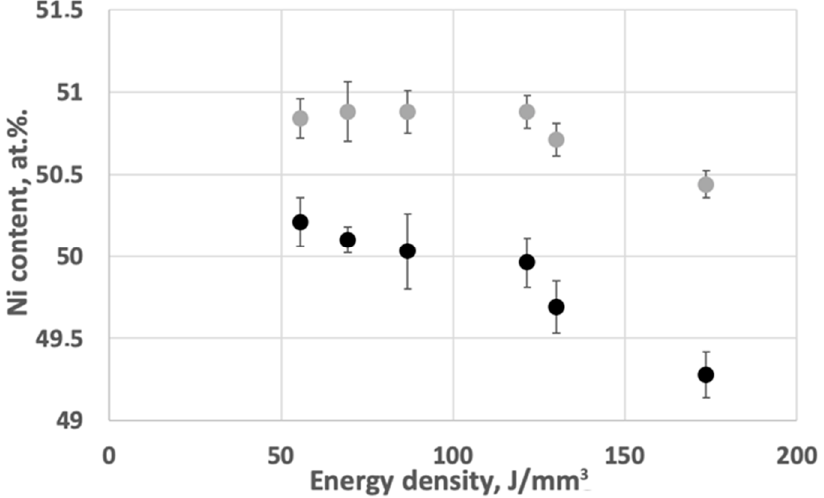
Figure 2. Dependence of the Ni content in compact samples on the bulk energy density during the SLM process. Black - NiTi 50.0, gray - NiTi 50.7.